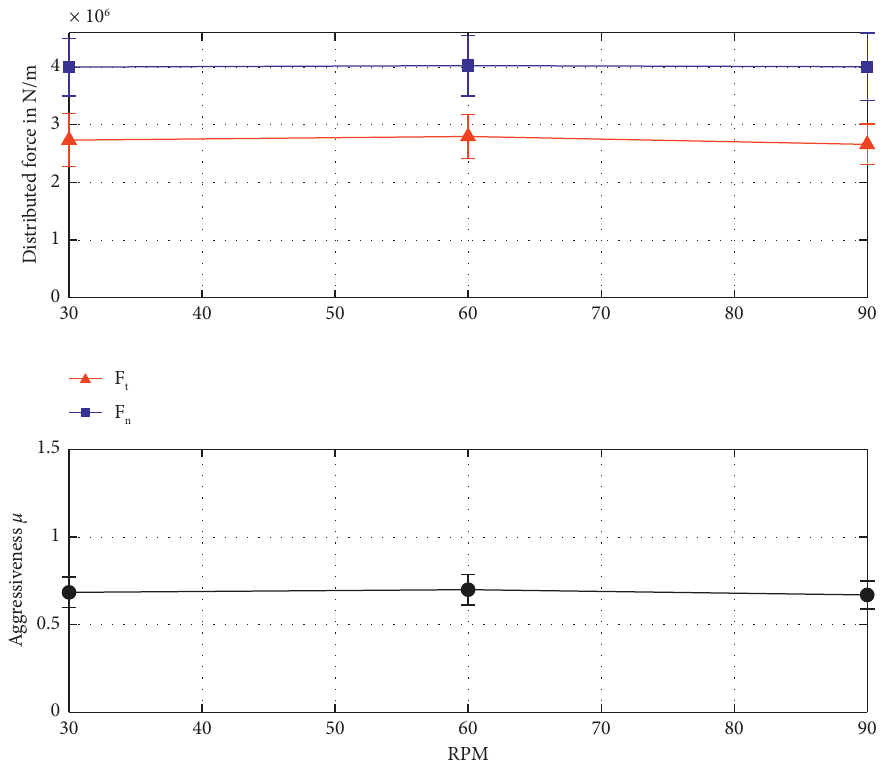
Figure 14: Averaged forces and aggressiveness at various cutting speeds under constant axial force control using the rate-independent model.